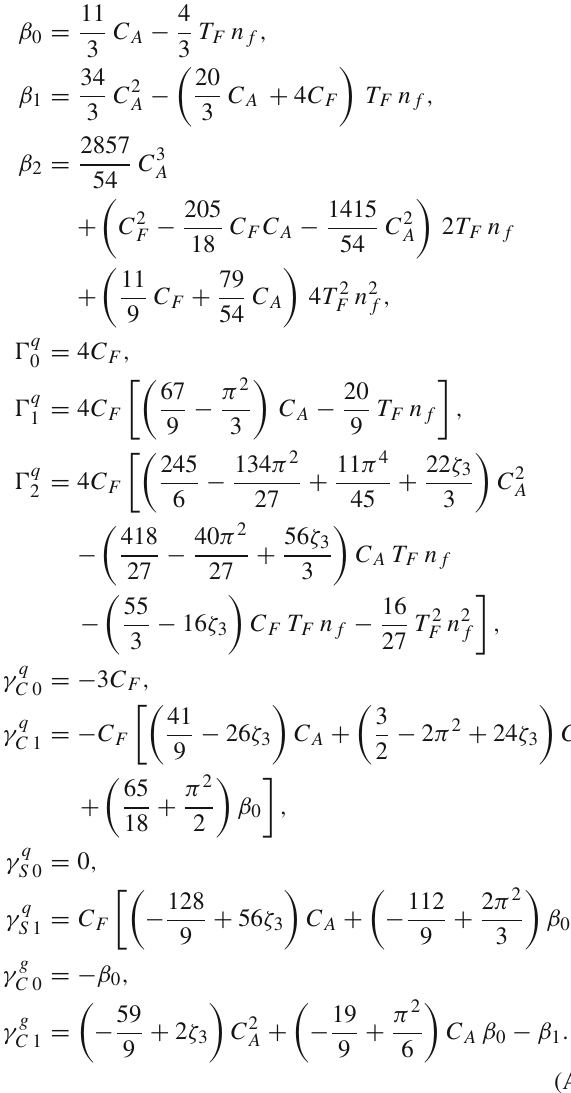
treatment of the full shape function in the nonperturbative peak region of the quark distribution, for example using the methods of Refs.